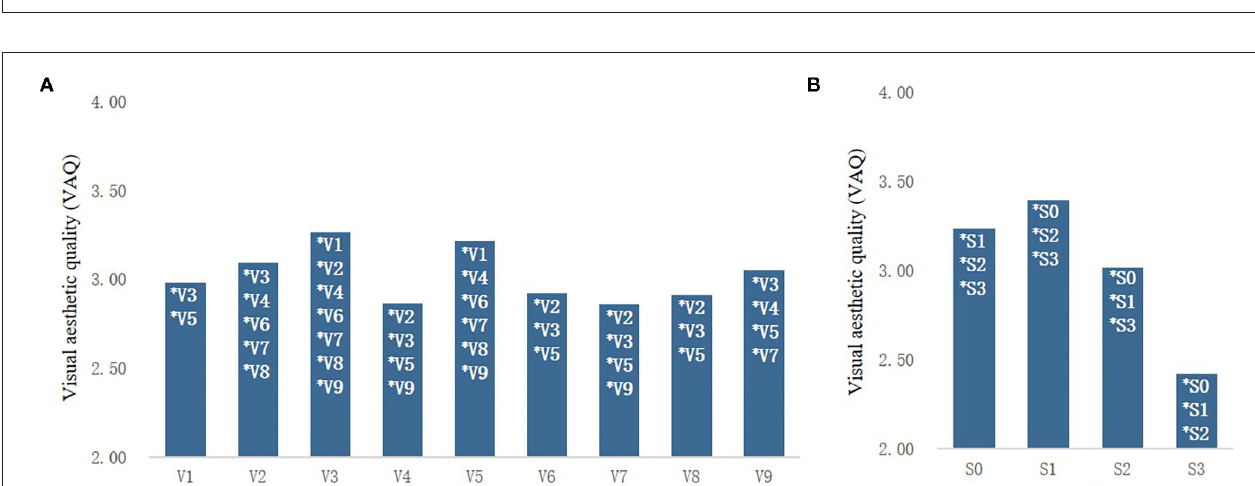
FIGURE 4 | Flow chart of single-person experiment for visual landscape and auditory soundscape evaluation.